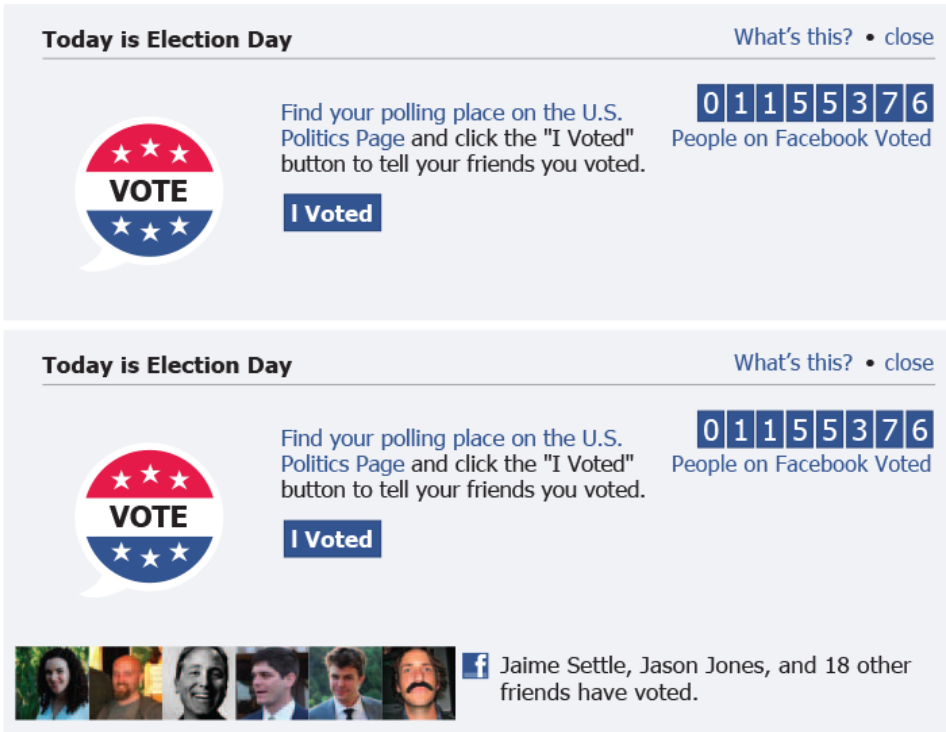
Figure 2: United States Election Day 2010 turn-out study experimental conditions: Informational group and social group (Bond et al.,